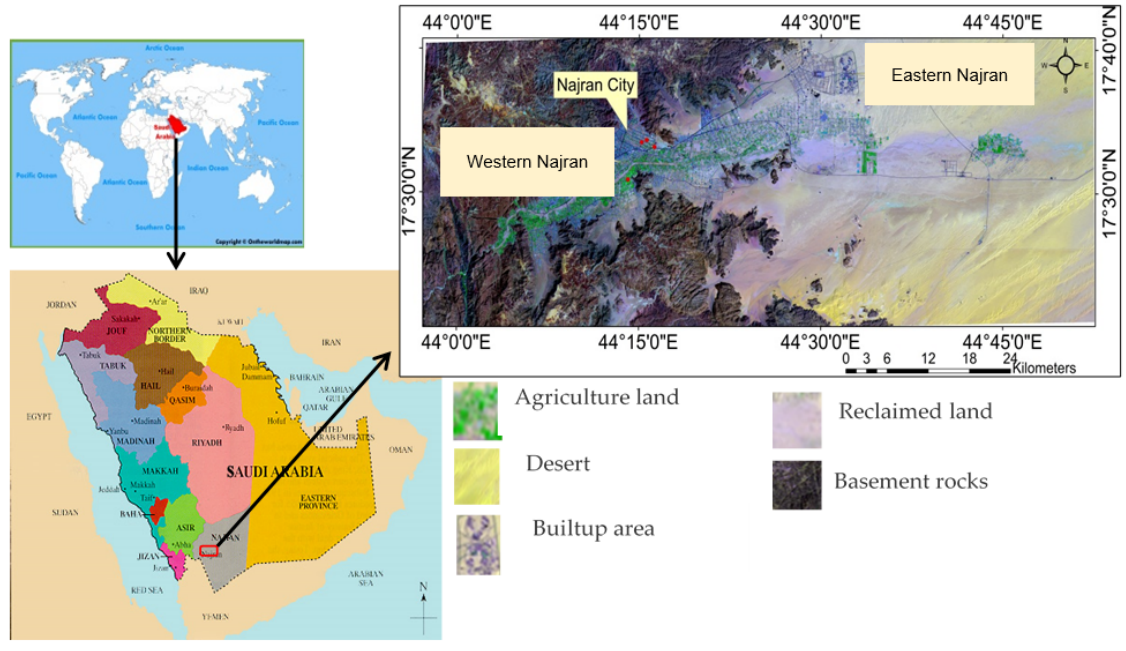
Figure 3. Location map of the study area [37].